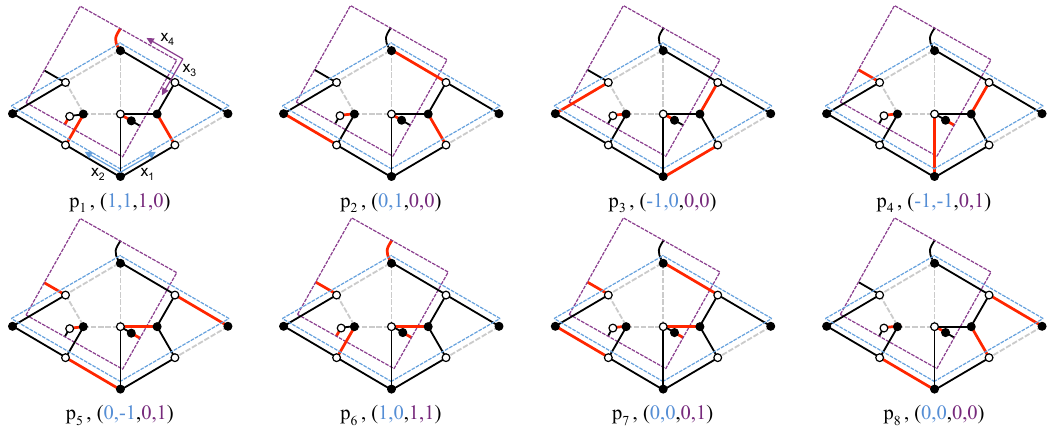
Figure 30. Surviving perfect matchings with the bridges and the genus 1